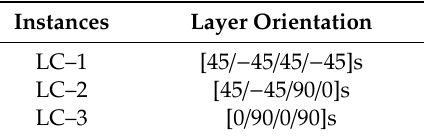
Table 3. Layer Table 3. Layer arrangements.